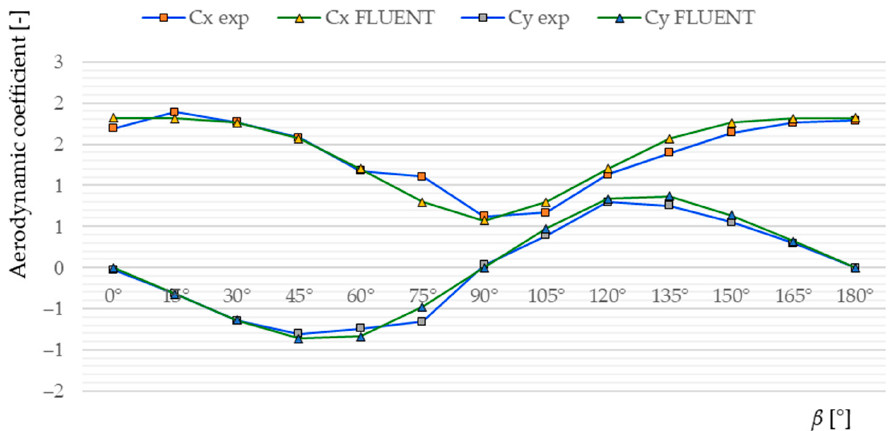
Figure 12. Comparison of the force coefficient C x and C y for the experimental and numerical results as function of angle of wind attack β at the case of configuration 3.